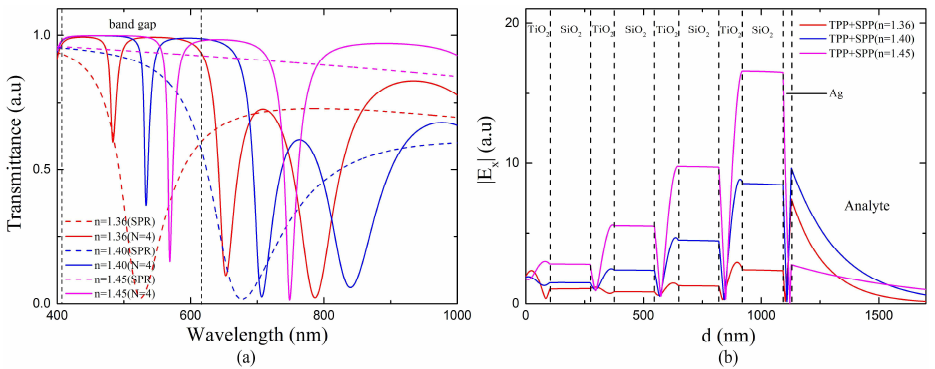
Figure 9. ( a ) Transmission spectra of the proposed sensor with different RI of the analyte at N = 4, λ 0 = 1000 nm, d m = 35 nm. The transmission spectra of the sensor with a single silver layer of 35 nm is also presented for comparison. ( b ) Tangential electric field distribution of TPP-SPP dip at the resonance wavelength 484 nm and the resonance angle of 87.02 ◦ , 533 nm and 87.56 ◦ , 569 nm and 87.9 ◦ for n s = 1.36, 1.40, 1.45, respectively.